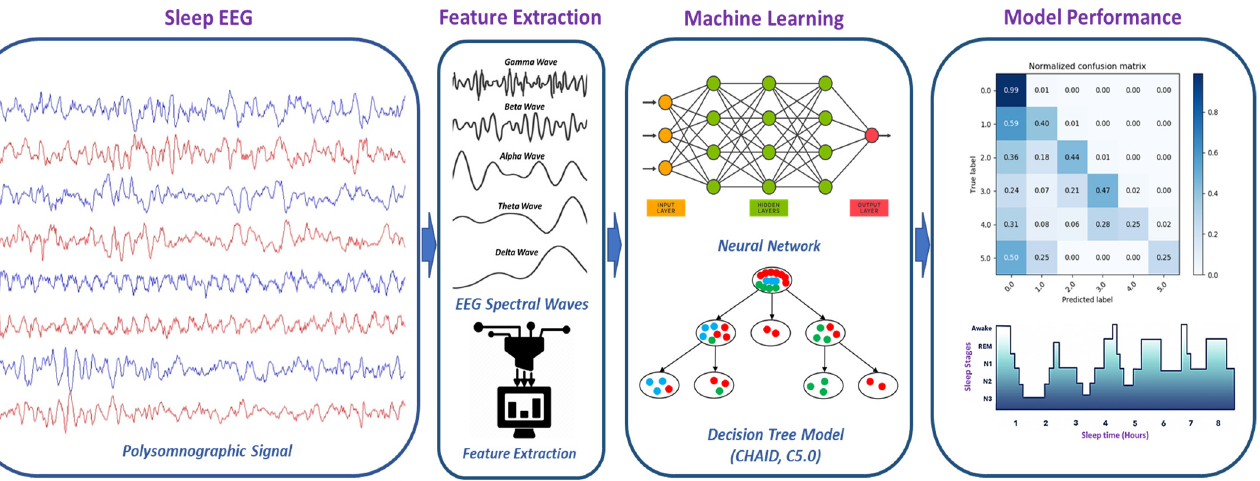
Figure 1. Methodology of EEG-based sleep stages classification using a machine-learning